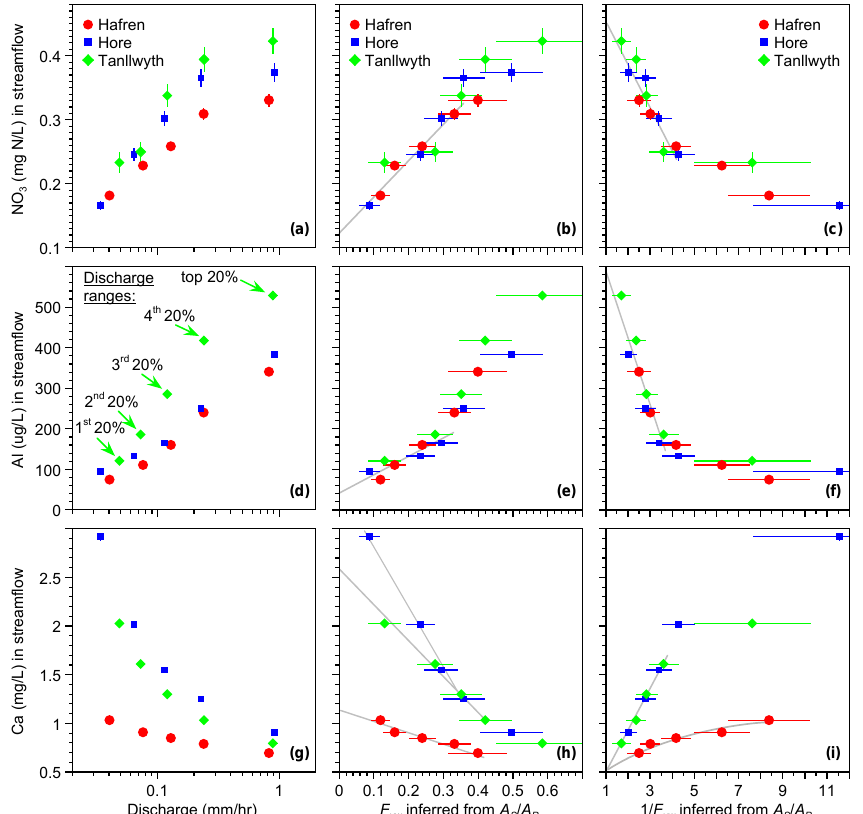
Figure 14. Concentrations of reactive chemical species as functions of discharge (left panels), young water fractions (middle panels), and reciprocal young water fractions (right panels) for streams draining three contrasting catchments at Plynlimon, Wales. Symbols show means for 20% intervals of each catchment’s discharge distribution, and error bars indicate ± 1SE (standard error). Gray lines are drawn by hand to indicate general trends. Concentration–discharge relationships in nitrate and aluminum differ among the three catchments (a, d) but collapse to single concentration– F yw relationships (b–c, e–f) . These concentration– F yw relationships extrapolate to broadly consistent old water end- members ( F yw = 0, b and e ) and young water end-members ( F yw = 1, d and f ). Calcium follows different concentration– F yw relationships in the three streams, which extrapolate to three different old water end-members (h) but roughly the same young water end-members (i)